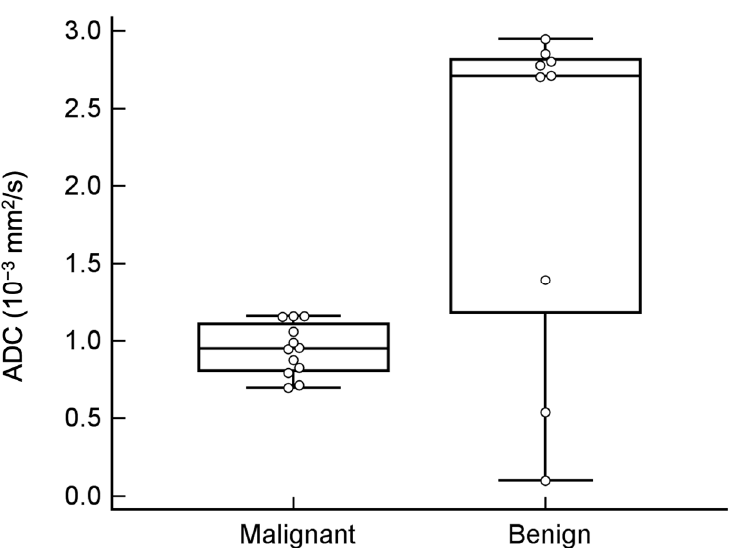
Figure 5. ADC values of tumors and areas under the receiver operating characteristic (ROC) curve (AUROCs). The ADC value of malignant tumors was significantly lower than that of benign tumors but with a remarkable overlap. Using an ADC value of ≤ 1.27 × 10 − 3 mm 2 /s to distinguish malignant from benign ovarian tumors with sensitivity and specificity were 100% and 77.8%, respectively.